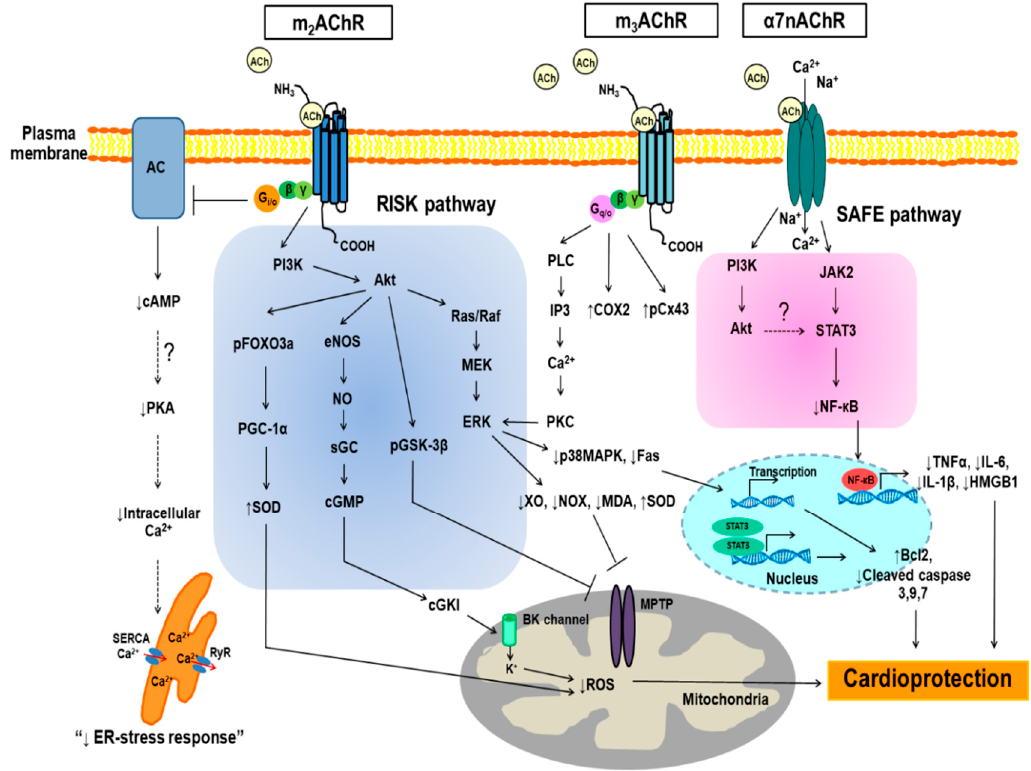
Figure 1. Simplified schematic representation of cardioprotective mechanisms via acetylcholine receptors in cardiomyocytes. Please note that this scheme does not entail the dimension of time. Acetylcholine confers cardioprotection against myocardial ischemia/reperfusion injury through both muscarinic and nicotinic acetylcholine receptors. The solid line indicates the known or published pathway and the dashed line represents hypothetical pathway; ( ⊥ ): proven inhibitory pathway; AC: adenylyl cyclase; ACh: acetylcholine; Akt: protein kinase B; α 7nAChR: α 7 nicotinic acetylcholine receptor; Bcl2: B-cell lymphoma 2; BK channel: voltage and Ca 2+ -activated potassium channel BK; cAMP: cyclic adenosine monophosphate; cGMP: cyclic guanosine monophosphate; cGKI: cGMP-dependent protein kinase type I; COX2: cyclooxygenase-2; pCx43: phosphorylated connexin